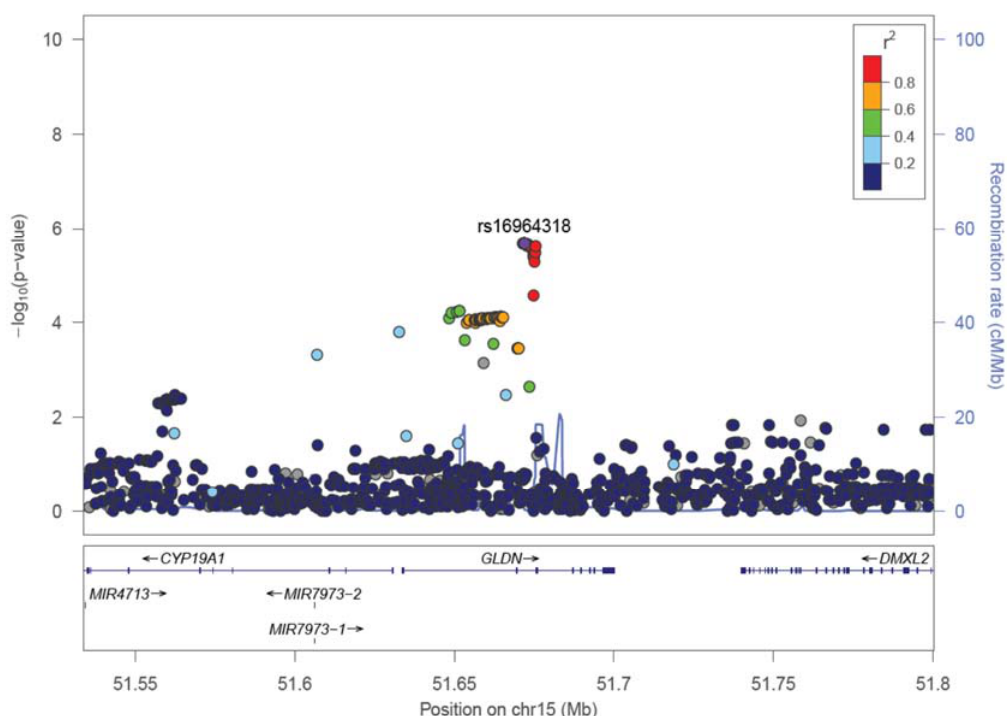
Figure 2. A representative regional plot of GLDN region. Added industrial/occupational factors were selected among industrial classification major groups in D, E, and H, i.e., “Manufacture